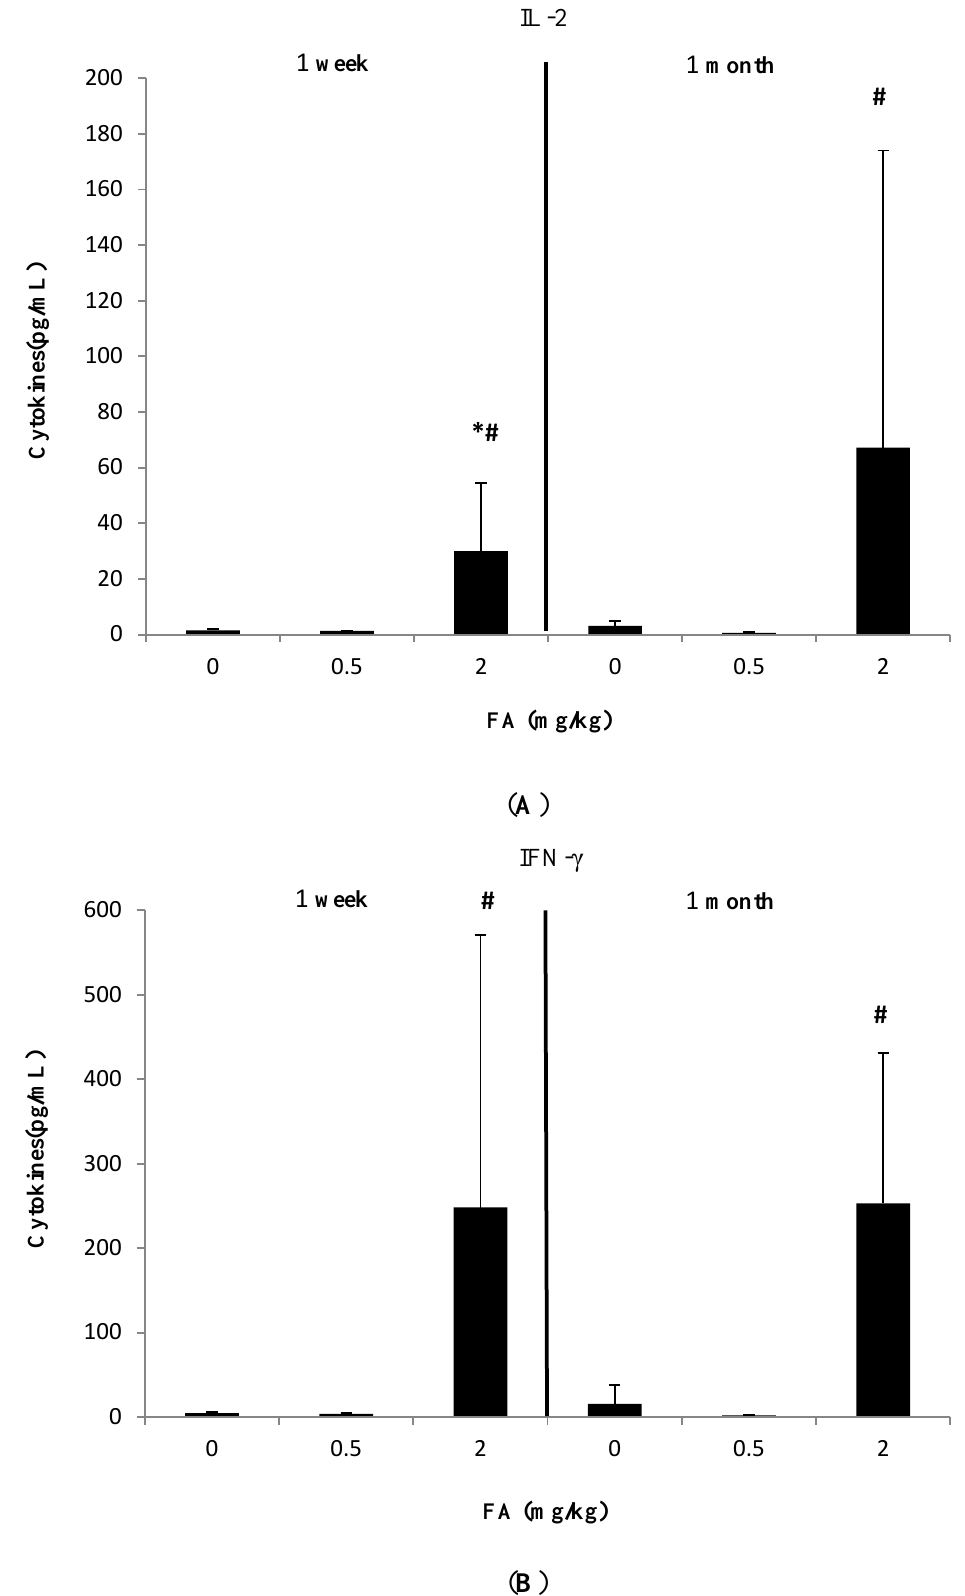
Figure 1. Effects of FA on IFN-γ, TNF and IL-2 (Th1-related cytokines ） in serum of C57BL/6 mice. ( A ) Effect of FA on IL-2 in serum of C57BL/6 mice; ( B ) Effect of FA on IFN-γ in serum of C57BL/6 mice; ( C ) Effect of FA on TNF in serum of C57BL/6